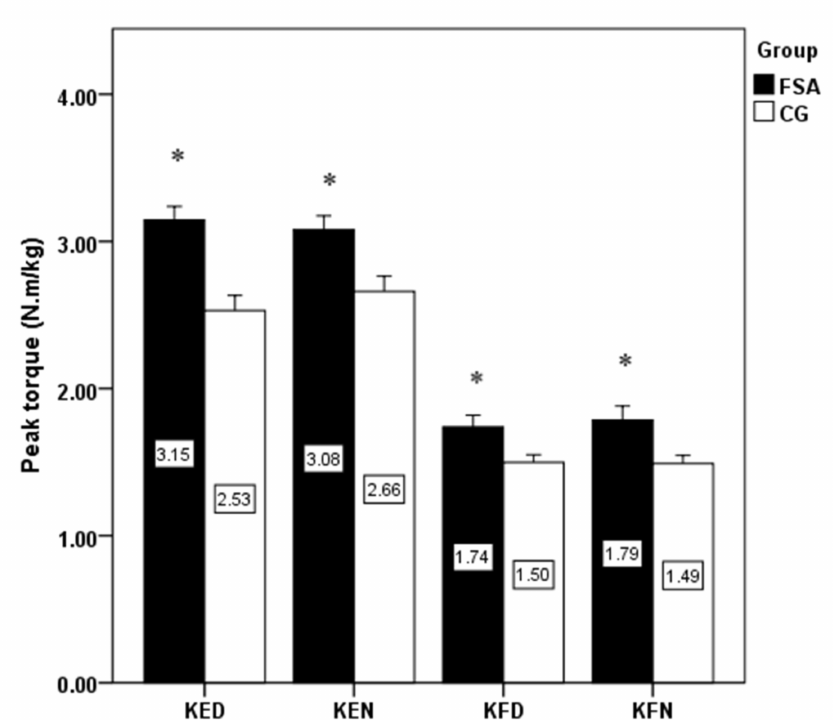
Figure 2. Comparison of peak torque differences between groups and limbs. Note: KED: knee extensors on dominant limb; KEN: knee extensors on non-dominant limb; KFD: knee flexors on dominant limb; KFN: knee flexors on non-dominant limb; FSA: fire sports athletes; CG: control group; *: significant difference between groups.